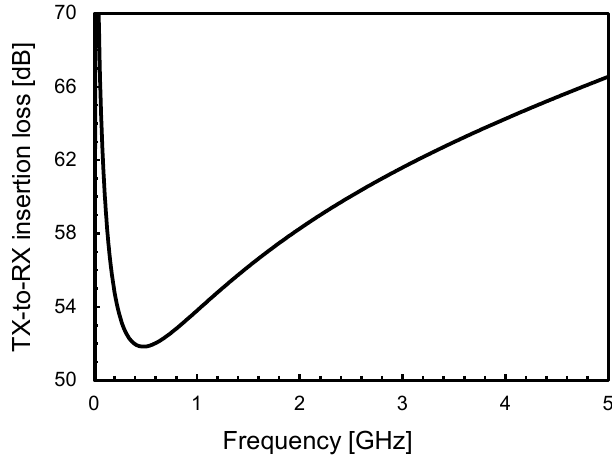
Figure 11. TX-to-RX coupling IL as a function of frequency. Table 2. Electrical parameters of TX and RX antennas.